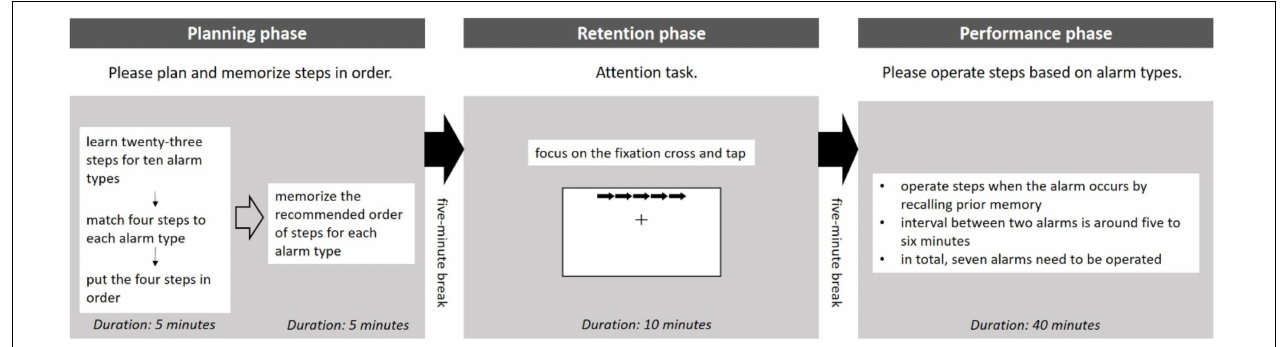
FIGURE 1 | An overview of prospective memory task